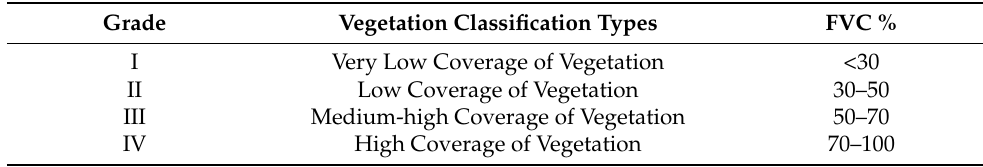
Table 1. FVC types in the Taitema Lake region.